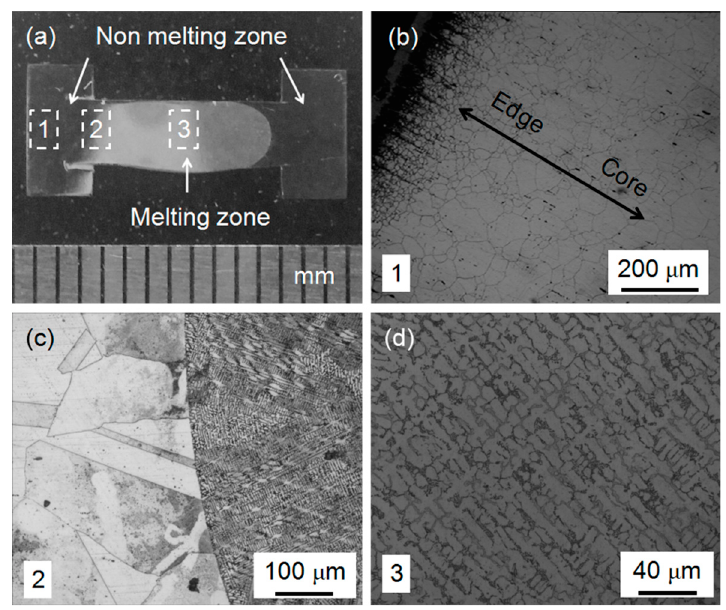
Figure 4. Photo and metallographic data of PQ SS304: ( a ) photo of PQ SS304; and ( b – d ) metallographic data of Selected Areas 1–3 of PQ SS304, respectively.